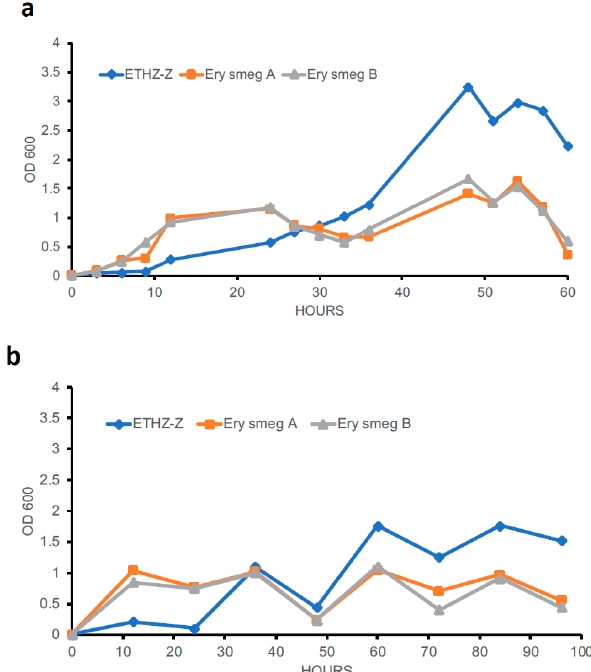
Figure 5. Growth profiles of the drug-susceptible and MDR Mycobacterium smegmatis strains. Overnight cultures of the three strains were diluted to an optical density at 600 nm (OD 600 ) of 0.01 and the growth rate was monitored for 60 h ( a ) or 96 h ( b ). For ( a ), the OD 600 was measured every 3 h for 12 h, followed by an intermittent 12-h measurement. For ( b ), the OD 600 was measured every 12 h for 96 h. Ery M. smeg A and Ery M. smeg B represent the two erythromycin-resistant clones derived from the Mycobacterium smegmatis mc 2 155